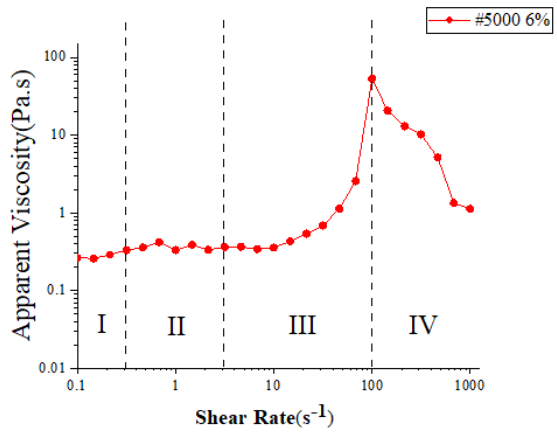
Figure 4. Rheological curves of 5000# diamond STP slurry at a concentration of 6 wt.%.